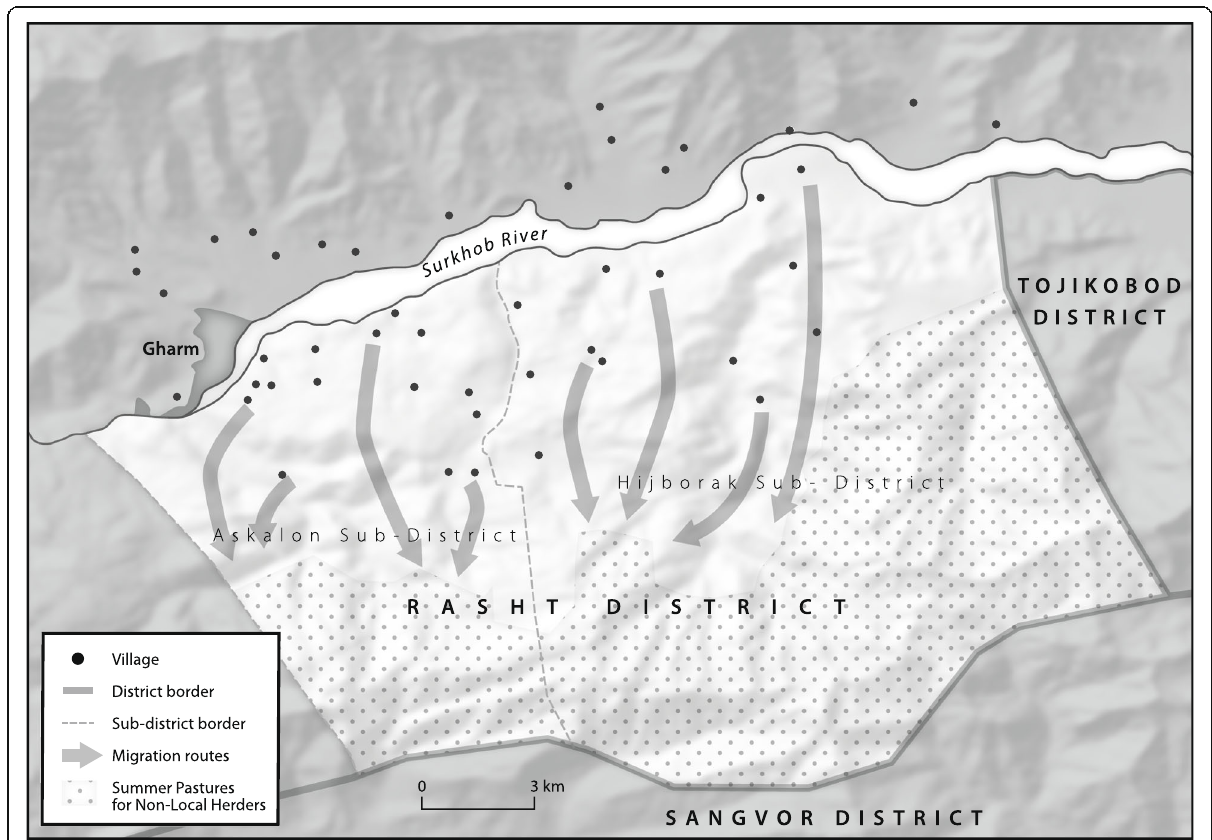
Fig. 2 Map of Askalon and Hijborak Sub-Districts in southern Rasht District. Arrows show general patterns of short-distance transhumance routes used by local herders in the study area. Dotted area is grazed solely by non-local